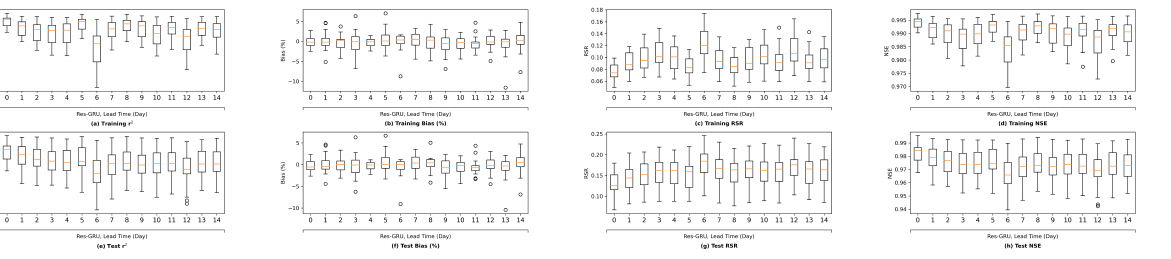
Figure 9. Salinity forecasting performance of Res-GRU.